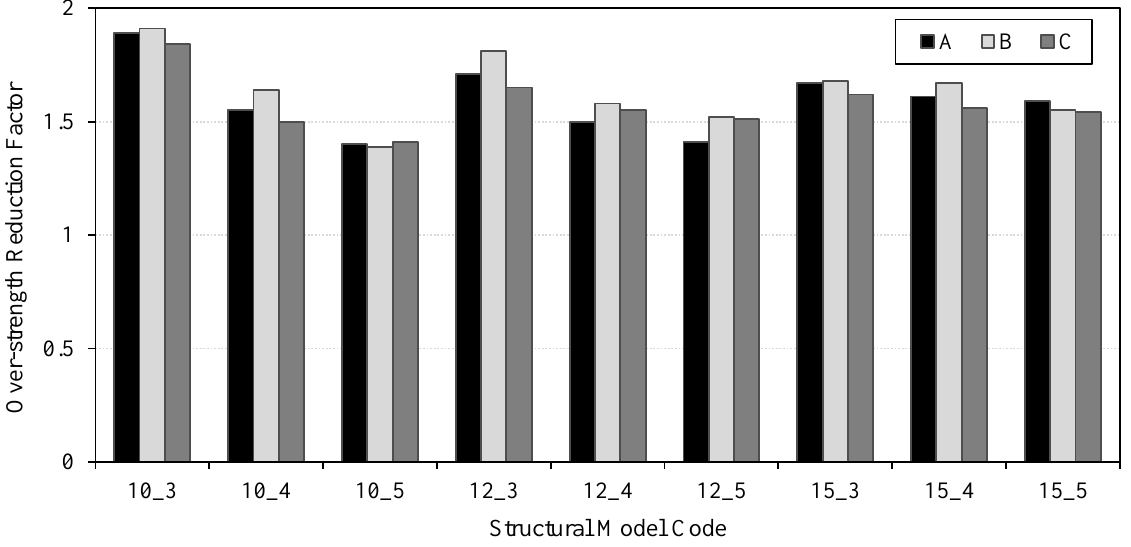
Fig. 8. Over-strength reduction factors of different models.